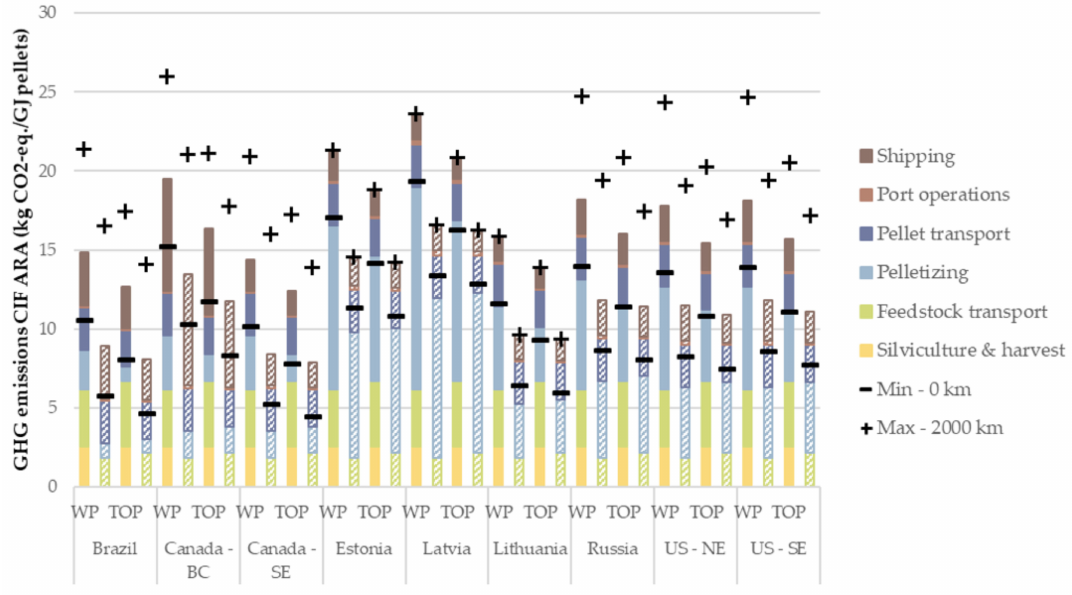
Figure 4. Supply chain greenhouse gas emissions for wood pellets and torrefied pellets made from pulpwood (solid) and sawmill residues (striped), for all analysed countries. Total emissions were based on feedstock transport distance of 50 km and pellet transport distance of 500 km. As a sensitivity, minimum and maximum values are shown based on transport distance of pellets between 0–2000